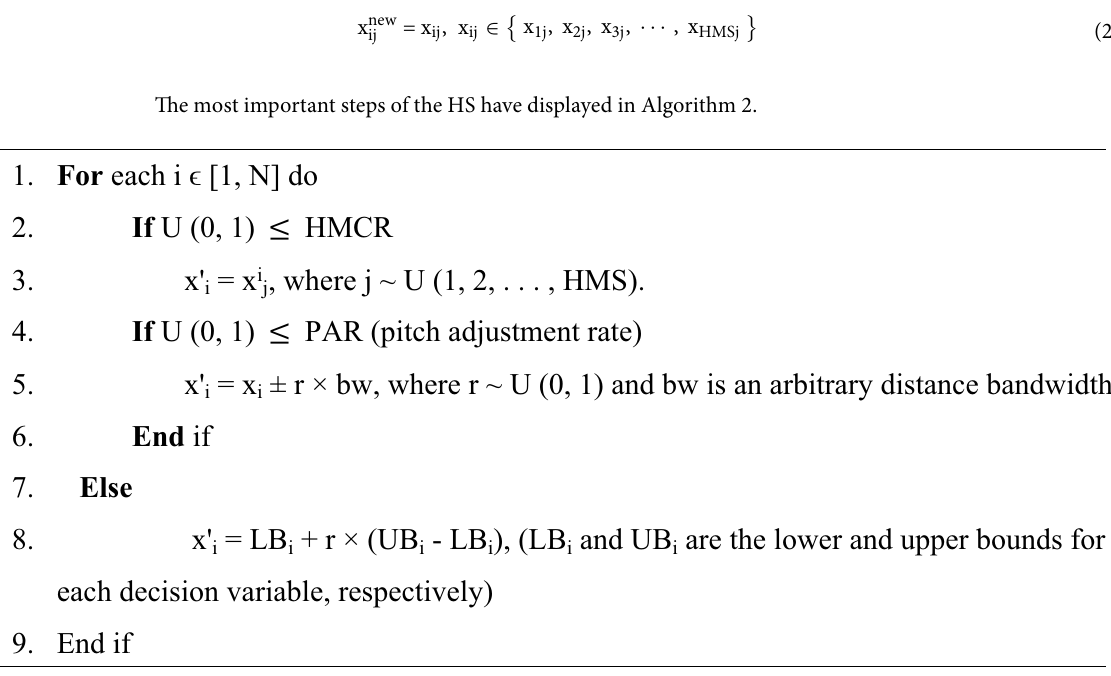
Algorithm 2: Pseudo-code of the HS